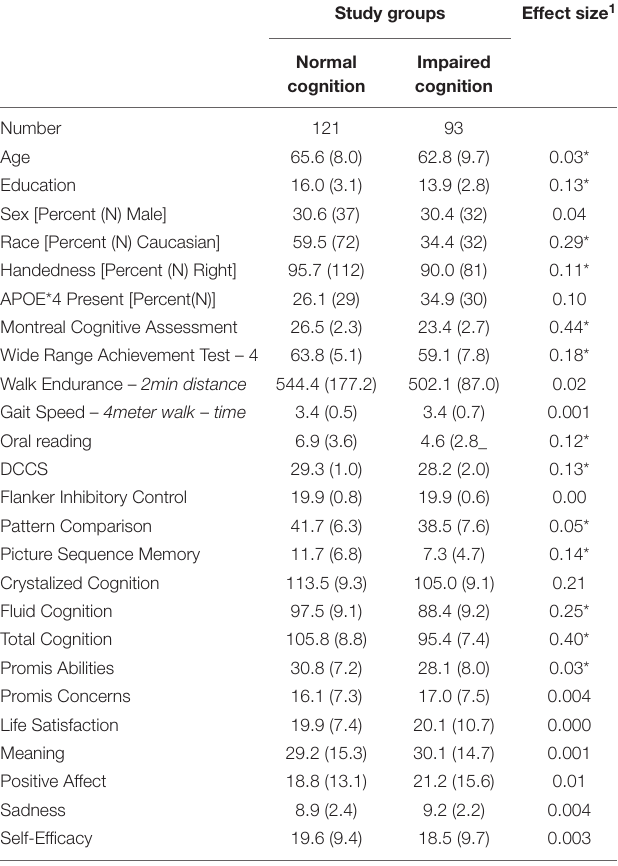
TABLE 1 | Characteristics of study participants as a function of initial classification.